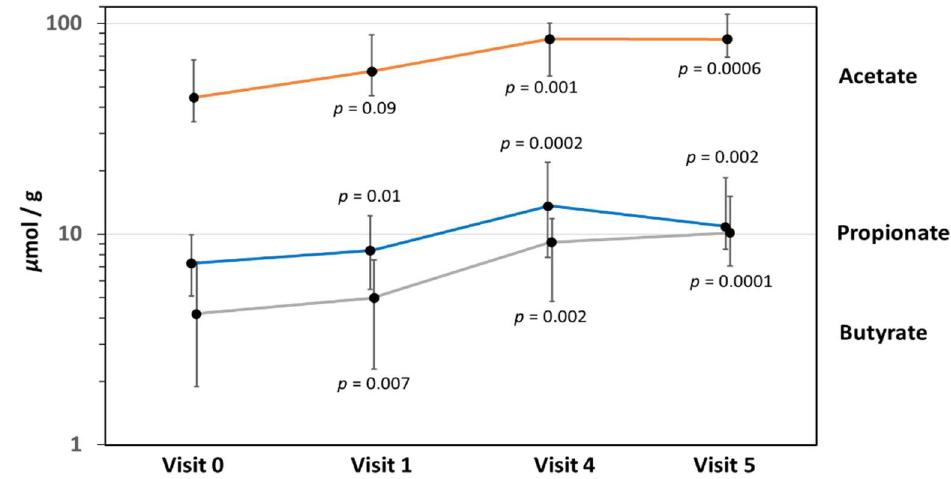
Figure 9. Mean fecal short-chain fatty acid concentrations for acetate, propionate, and butyrate (error bars indicate standard deviation). p -values are shown for the two-sample t -test comparing the baseline (V0) levels with those at the follow-up after 1 month (V1), 4 months (V4), and at 12 months of age (V5).